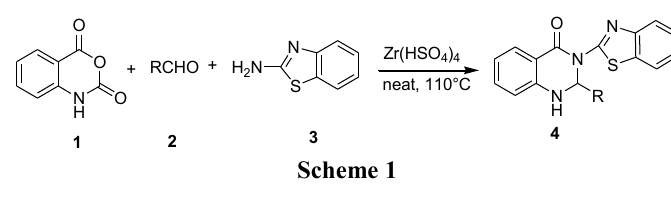
Table 1. Synthesis of 3-(2′-benzothiazolyl)-2,3-dihydro-2-(phenyl)-quinazolin-4(1 H )-one under various conditions a